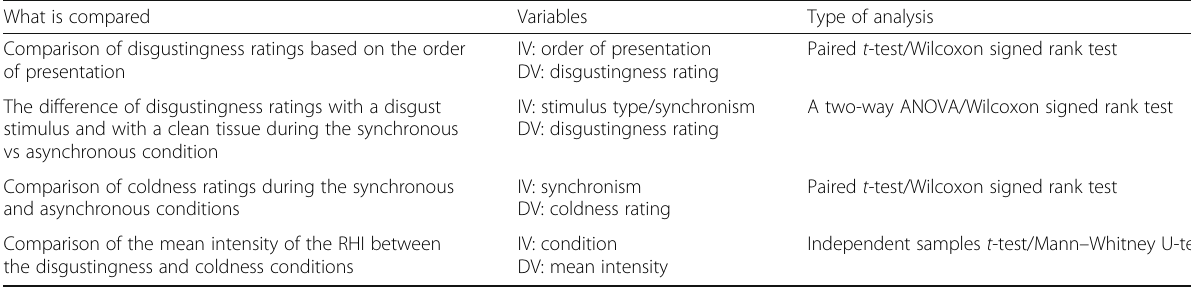
IV: order of presentation Paired t -test/Wilcoxon signed rank test DV: disgustingness rating